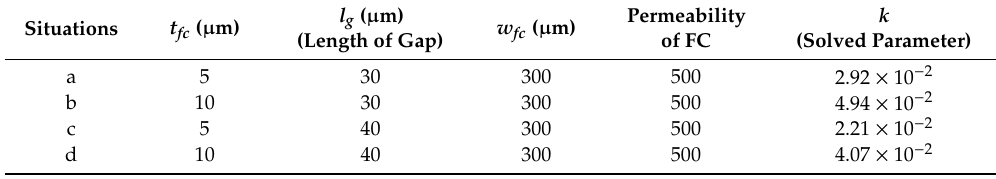
Table 1. Parameters in different situations.